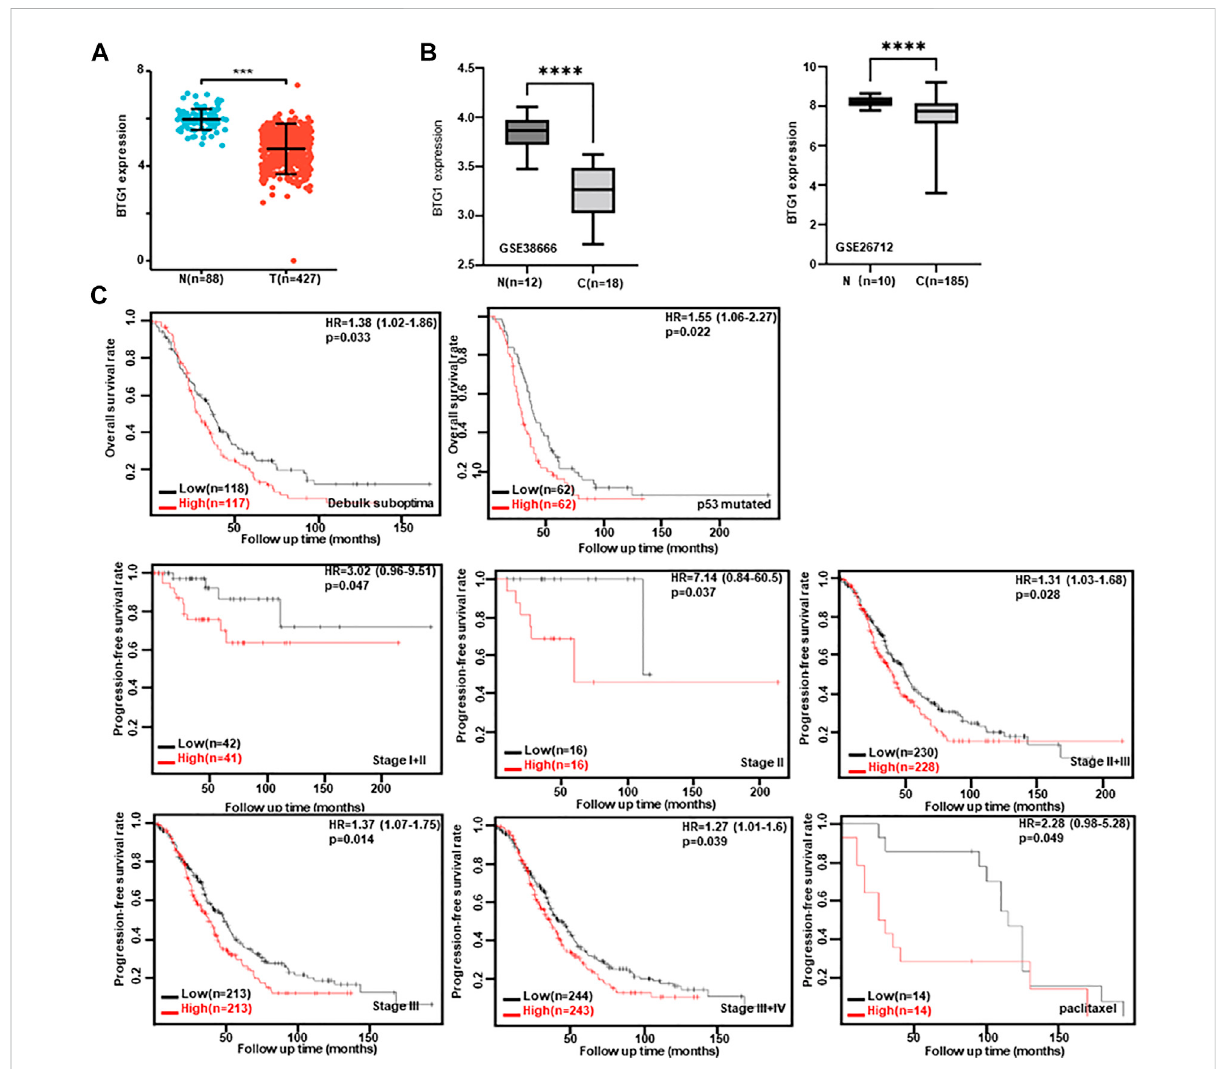
FIGURE 4 Theclinicopathologicalandprognosticsigni fi cancesof BTG1 mRNAexpressioninovariancancer.Bothxiantao (A) andGEO (B) databaseswere employed for bioinformatics analysis to observe BTG1 expression in ovarian cancer. A lower BTG1 expression was detectable in ovarian carcinoma than normal tissue ( p < 0.05). The correlation between BTG1 expression and overall, or post-progression survival rate of the patients with